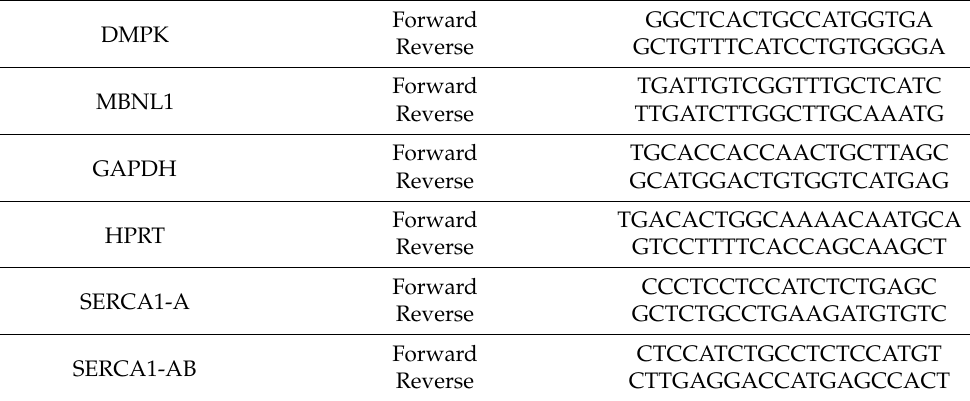
Table 1. Primer sequences for human